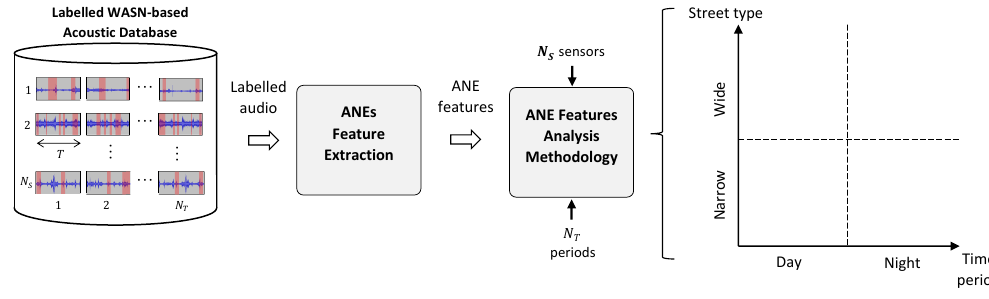
Figure 2. ANE feature analysis methodology from a labelled WASN-based acoustic